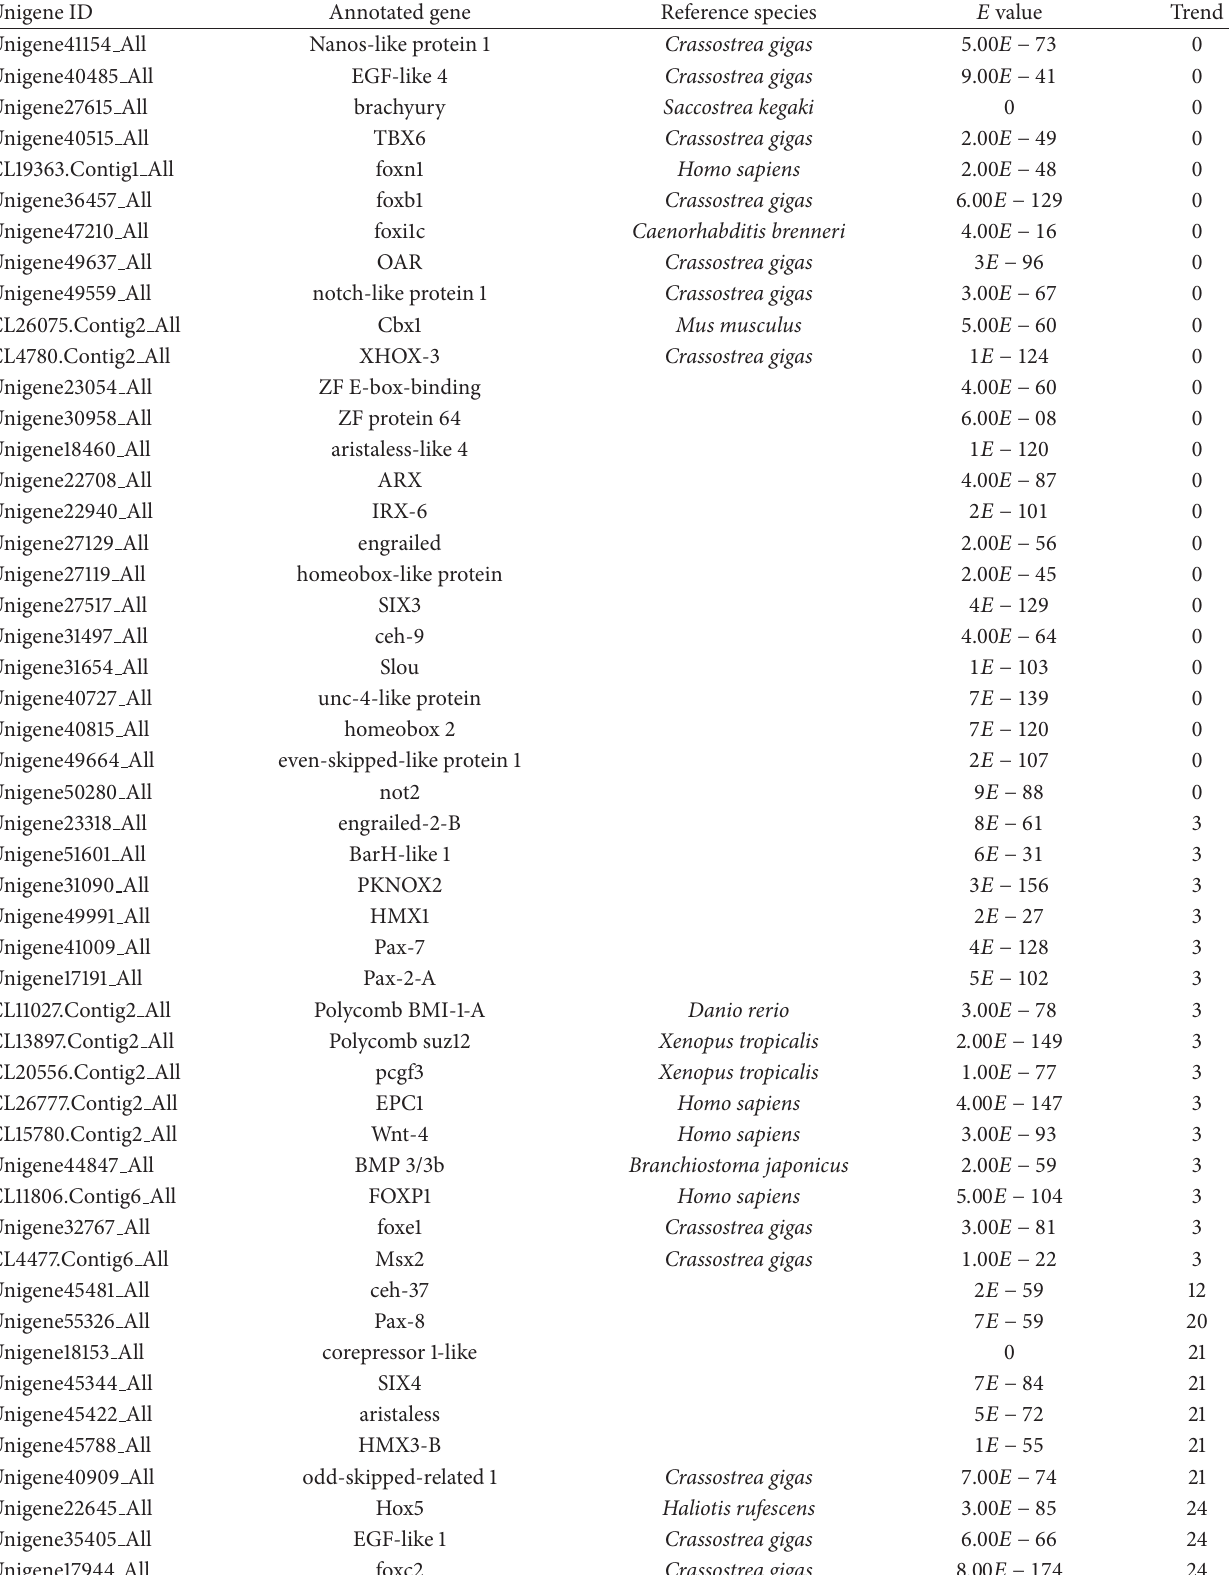
Table 5: Early development-related DEGs and their expression trends in Pinctada fucata